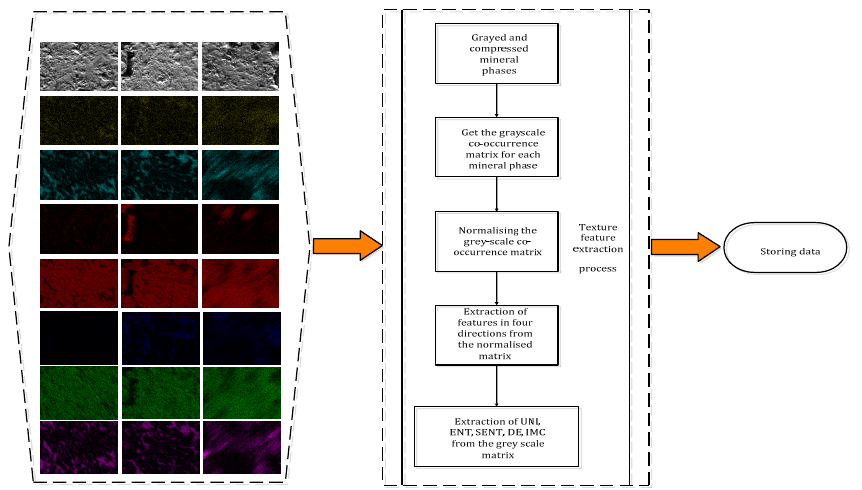
Figure 1. Extraction process of pellet phase texture